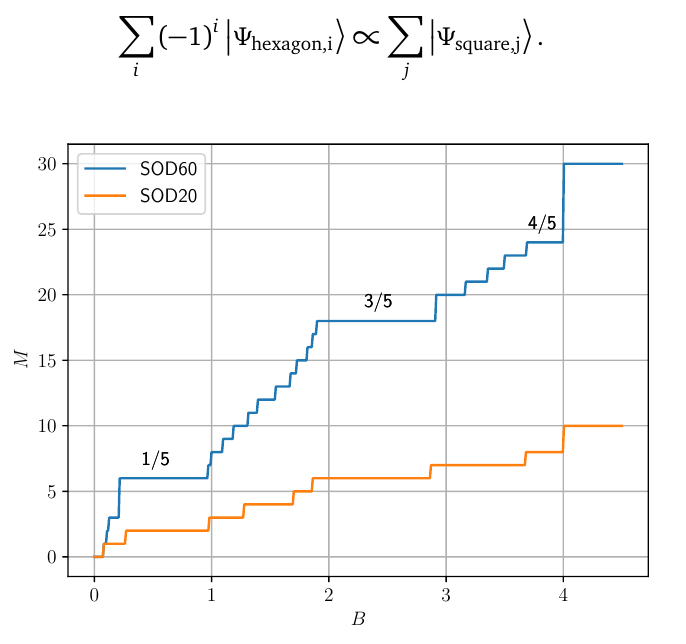
(cid:10) (cid:11) (cid:80) S z as a function of the applied magnetic field B i i